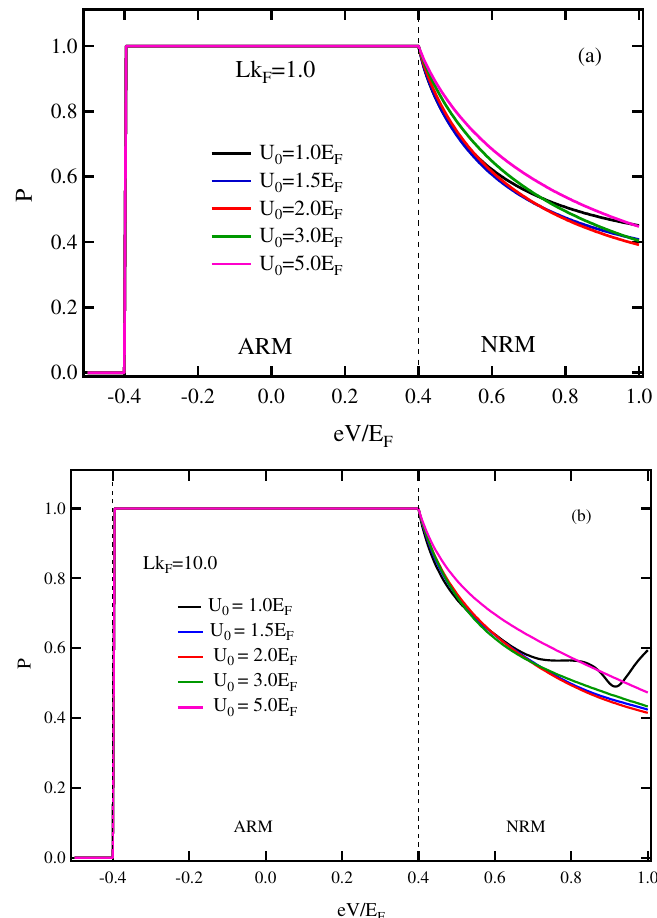
Figure 6. (Color online) Spin polarization of current in the applied voltage for different values of the barrier potential in case of M 2 > E α . ( a ) Lk F = 1.0, ( b ) Lk F = 10.0. The parameters were set as the same in Figure